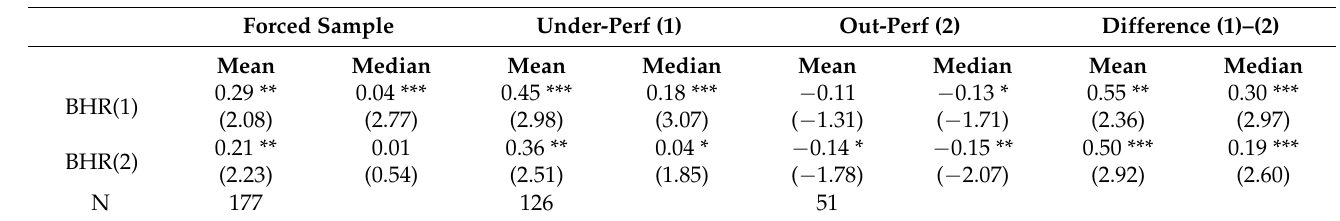
Panel B: Post Turnover 3-Year BHAR for the Forced Sample